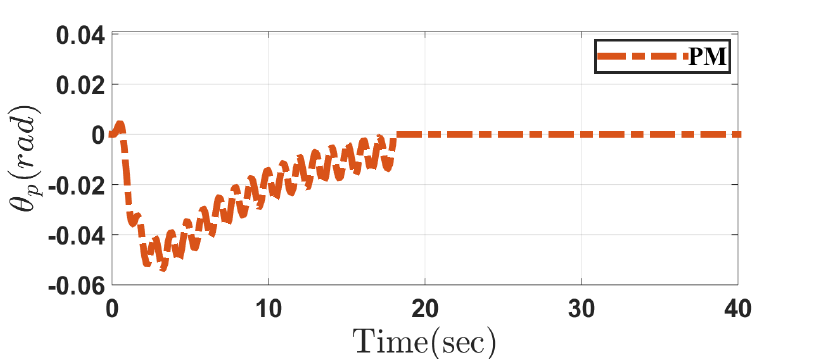
Figure 21. Movable mechanism angle in the proposed method (PM) in Case